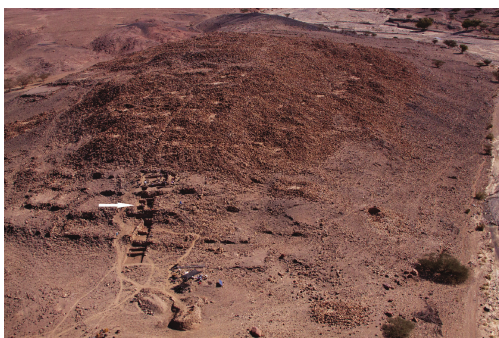
Figure 1: Aerial view of Khirbat Faynan looking east showing the excavation trench and excavators. Geophysical surveys were made around the entire site. Scale, note that the trench is 40 m in length from west to east. Arrow indicates the location of 3D ERT survey (photo, UCSD Levantine Archaeology Lab).